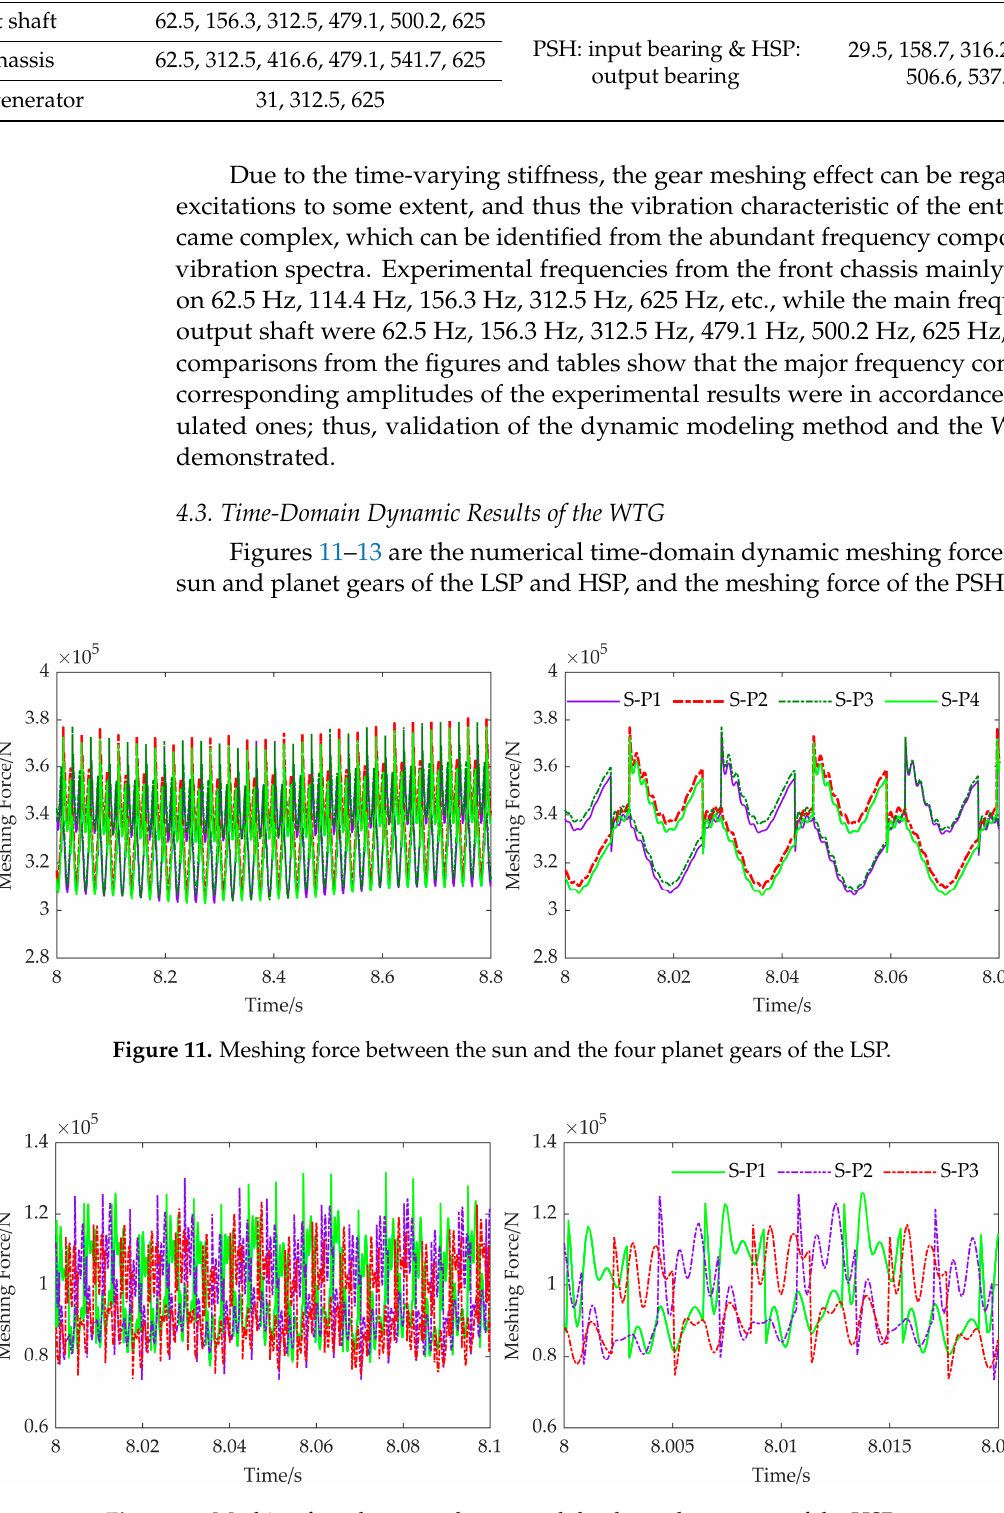
Figure 13. Meshing force between the input and output gears of the PSH. On this basis, the dynamic loading factors between gears, which are significant for the design stage, were calculated to be 1.12, 1.37 and 1.27 and are listed in Table 9. The results were different from the chosen factors of 1.02, 1.08, 1.07 obtained from an experi- ential manual. Under larger dynamic loadings that exceed the design limits, gear cracks may occur. Further dynamic examinations of the whole system in both the frequency and